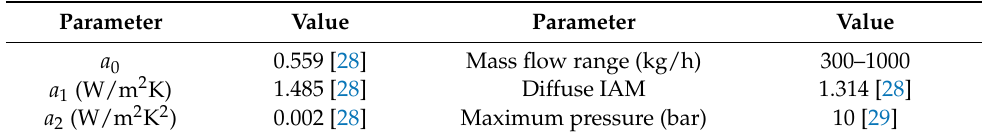
Table 1. Optical and thermal properties of the solar collector used in the simulations.